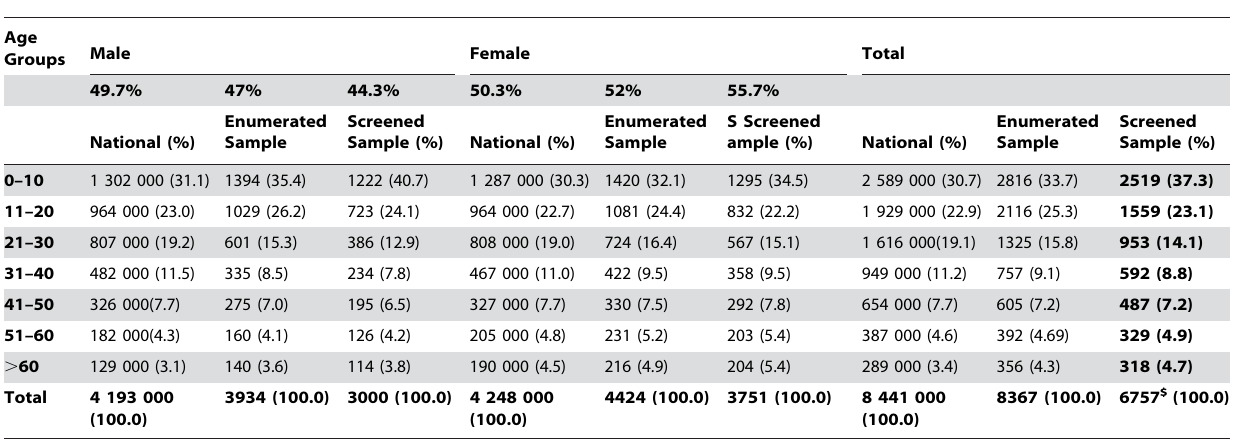
Table 1. Age and gender composition of national* and screened sample population.